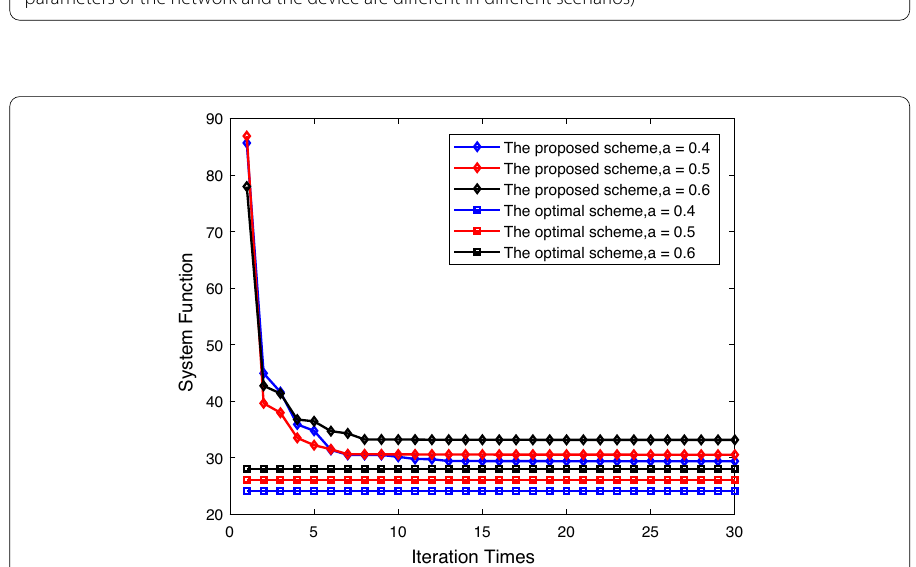
Fig. 9 The value of the system function of the proposed scheme and the optimal scheme versus different parameter a ( a refers to the ratio of T 1, k to T 2, k mentioned above) and iteration times here refers to the outer loop in Algorithm